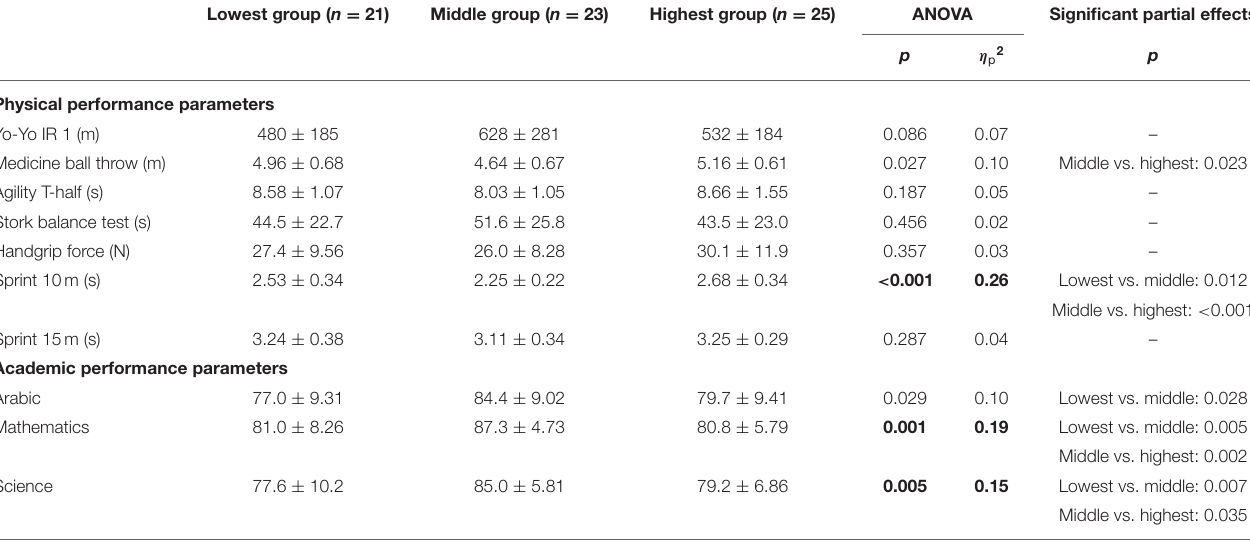
TABLE 3 | Comparison of physical performance and academic characteristics between three groups (differentiation criterion: percent body